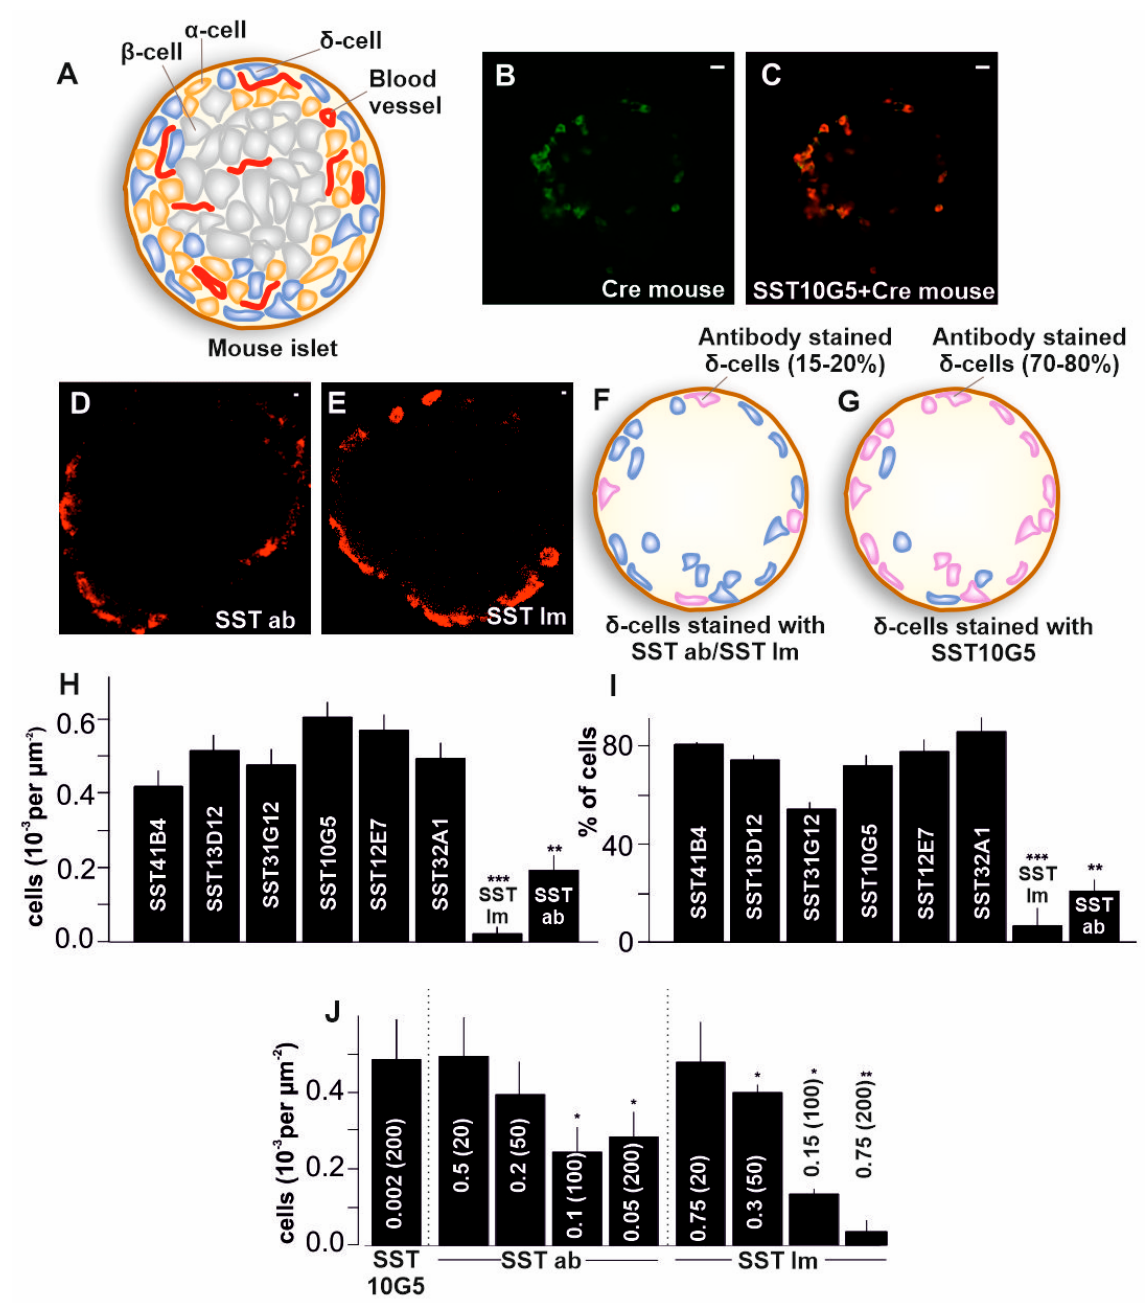
Figure 1. Co-localization of immune-stained δ -cells with transgenic islets—( A ) Cartoon depiction of a mouse islet showing the α , β and δ -cells, ( B ) View of islet from SST-iCre mice with δ -cells represented in green (Scale bar = 10 µm), ( C ) Islets from SST-iCre mice labelled with δ -cell specific antibody SST10G5 (Scale bar = 10 µ m), ( D ) Islets from SST-iCre mice labelled with SST-14 specific